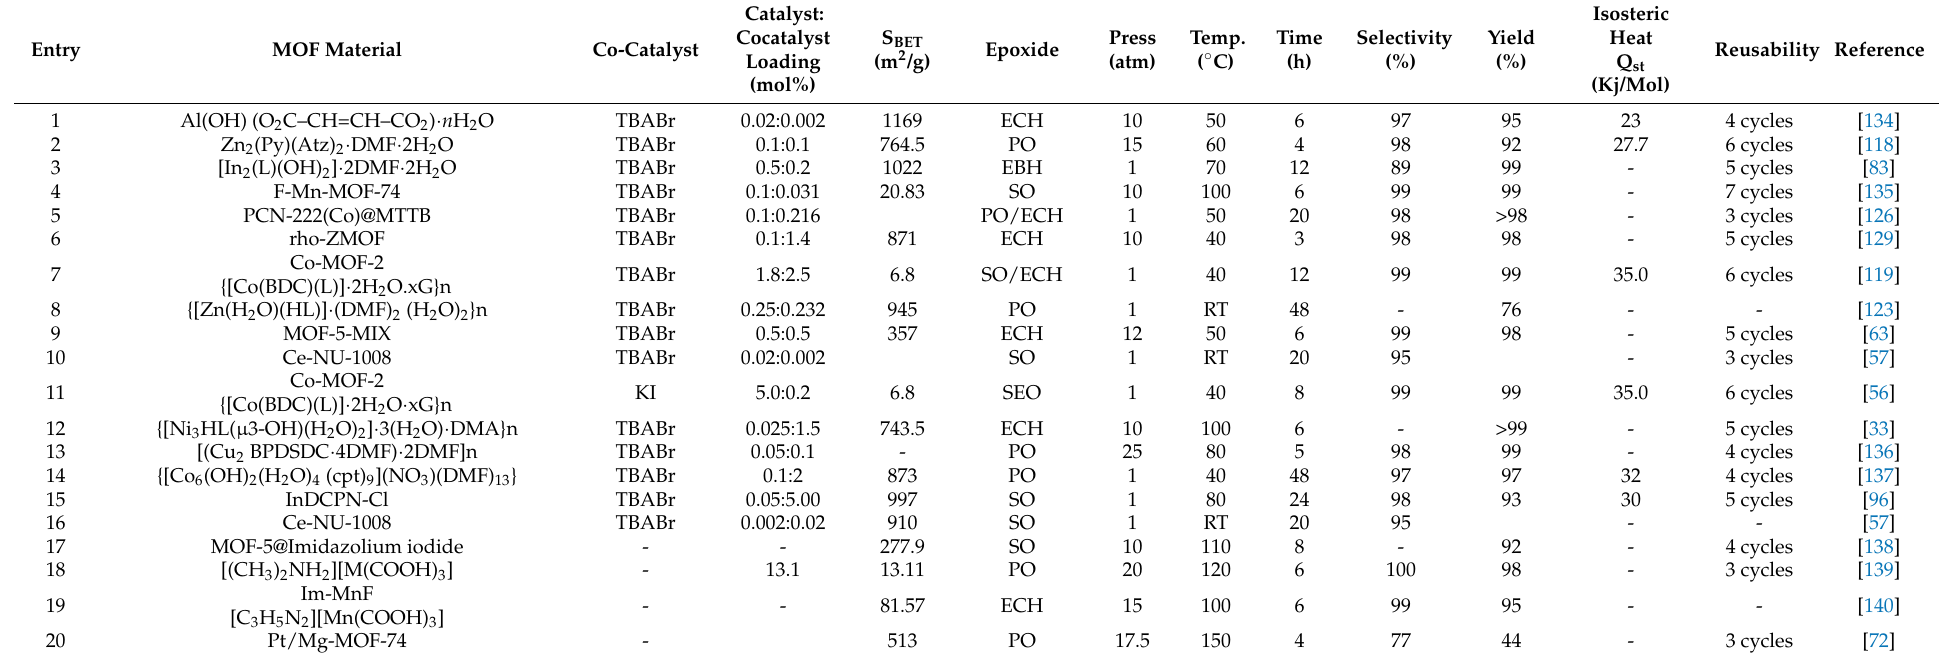
Table 1. Recent studies of MOF catalysts in CO 2 cycloaddition reaction to epoxides with reaction